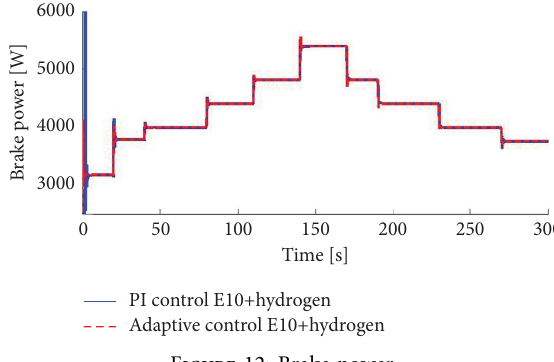
Figure 12: Brake power.